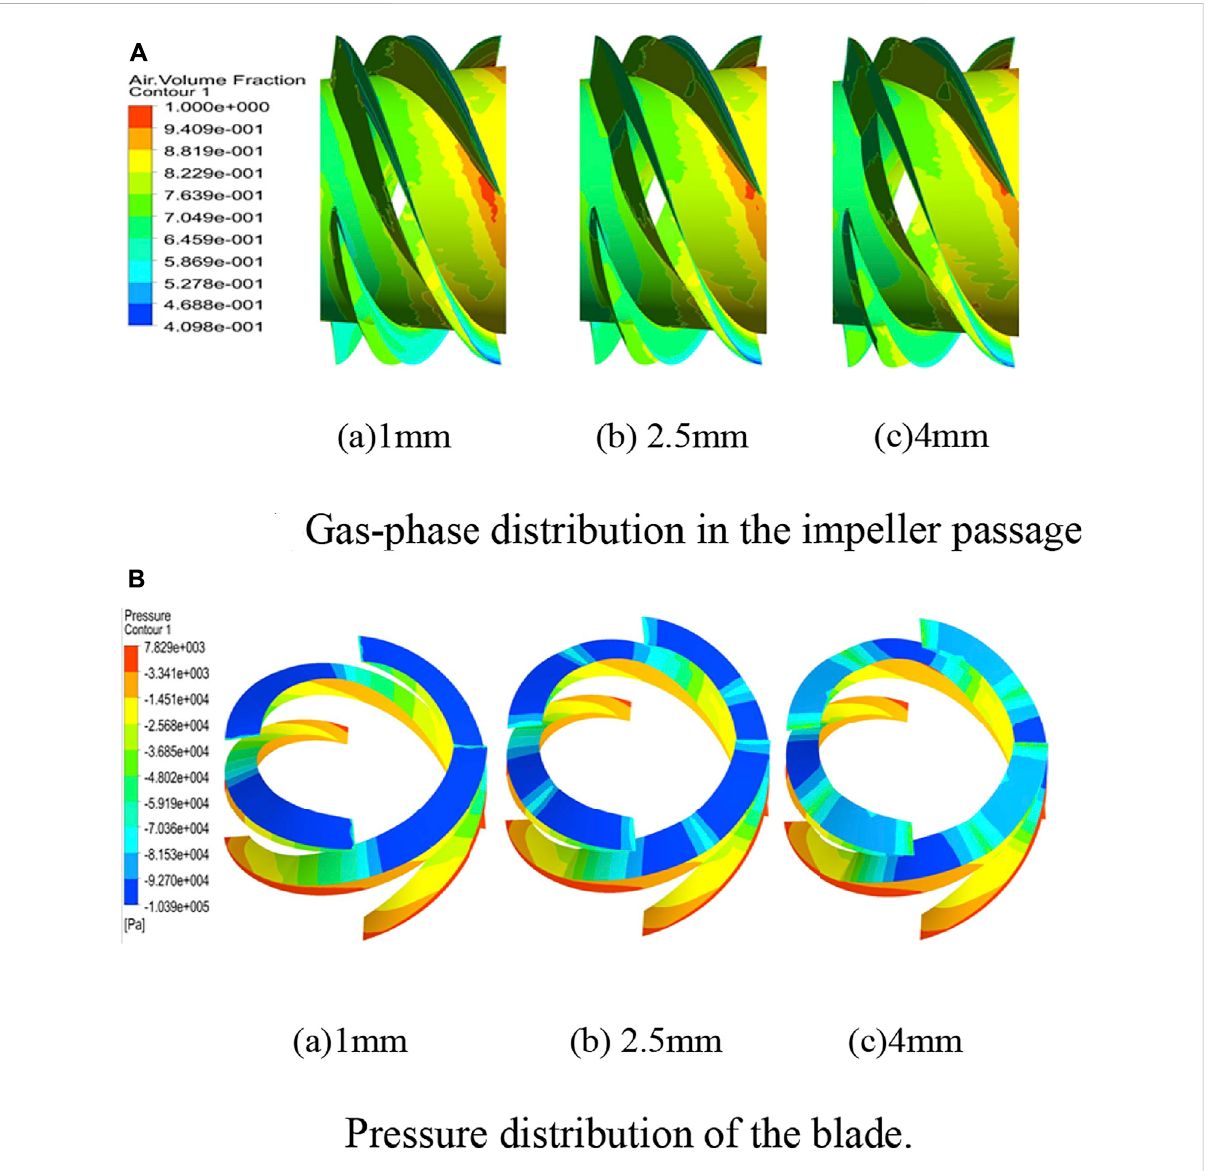
FIGURE 11 Cloud diagram of gas phase and pressure distribution. (A) Gas-phase distribution in the impeller passage. (B) Pressure distribution of the